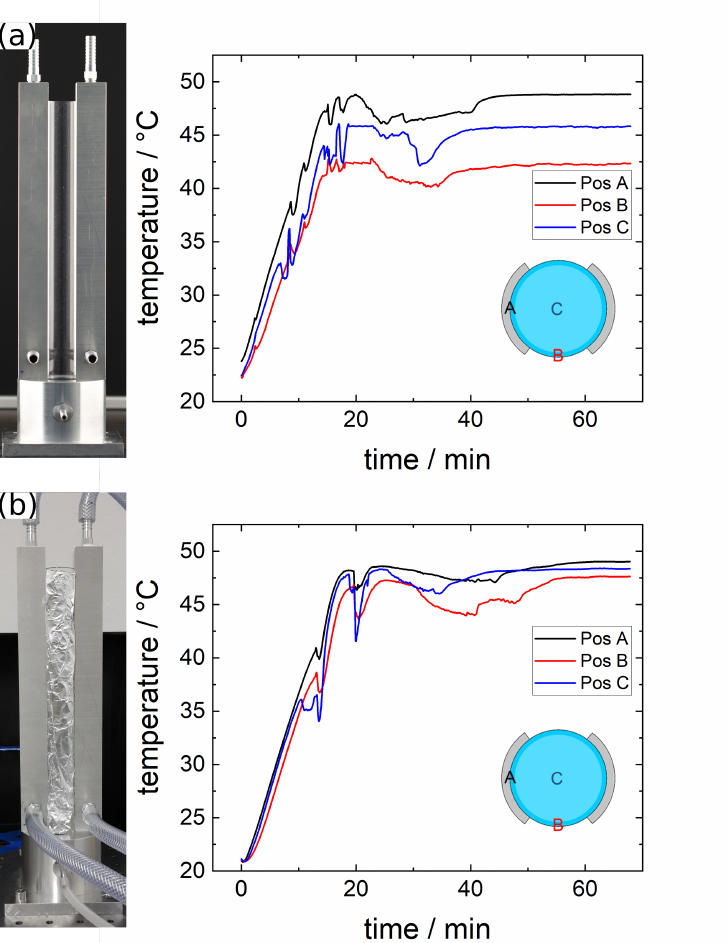
Figure 4. Evolution of the temperature of a tetradecyltrimethylammonium bromide (C 14 TAB, c = 3.5mM) foam in the foam cylinder without ( a ) and with ( b ) aluminum foil cover. The tem- perature was monitored using three Pt-100 temperature sensors at positions depicted by the